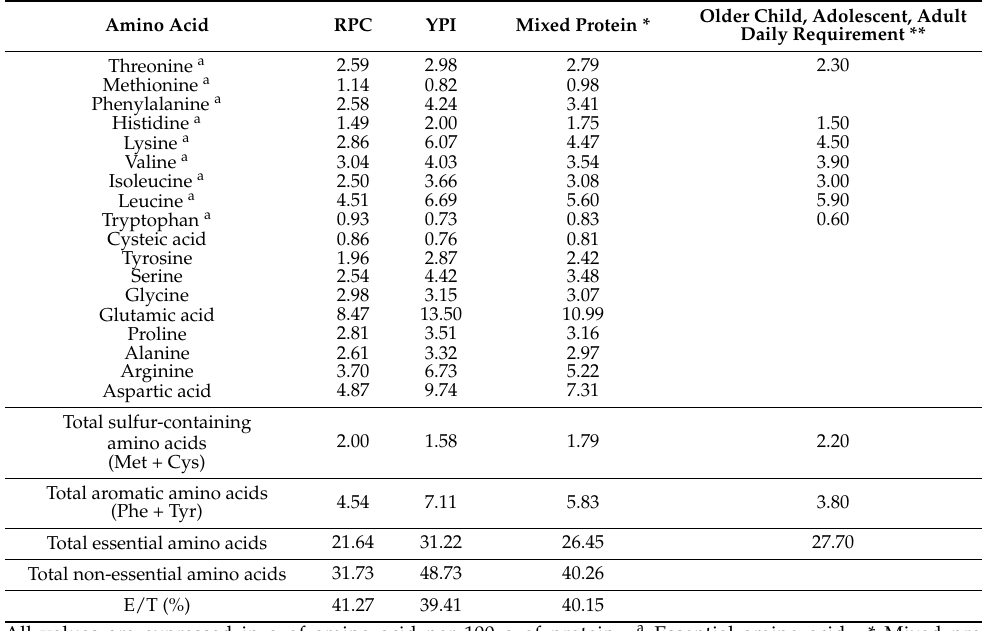
Table 5. Amino acid composition (g/100 g protein) of RPC, YPI, and mixed protein, and the FAO/WHO-suggested requirements (adult) of essential amino acids.